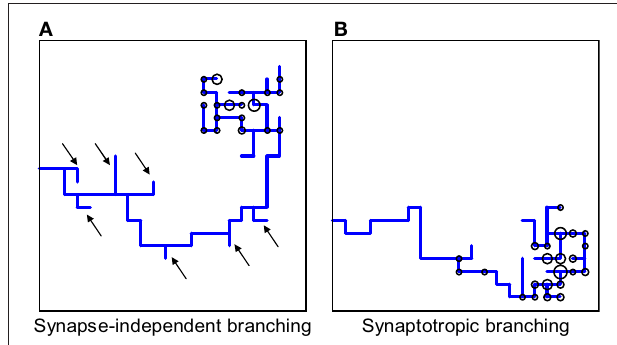
FIGURE 7 | Comparing synapse-independent branching and synaptotropic branching for axons. (A) If the branching is synapse- independent, new branches are formed along all segments of the arbor, both proximal and distal to the correct TZ. (B) In the case of synaptotropic branching, new branches are formed only along the arboreal segment closest to the correct TZ, and there are no erroneous branches formed along segments that are far away from its future TZ [marked by arrows in (A) ]. Thus, synaptotropic branching allows for axons to reach the correct TZ using fewer